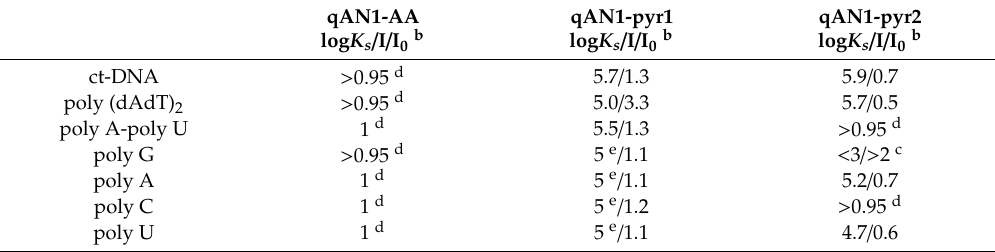
Table 1. Binding constants (log K s ) a and emission change (I / I 0 ) b calculated from the fluorescence titrations of compounds with ds- and ss- polynucleotides at pH 7.0 (sodium cacodylate bu ff er, I = 0.05